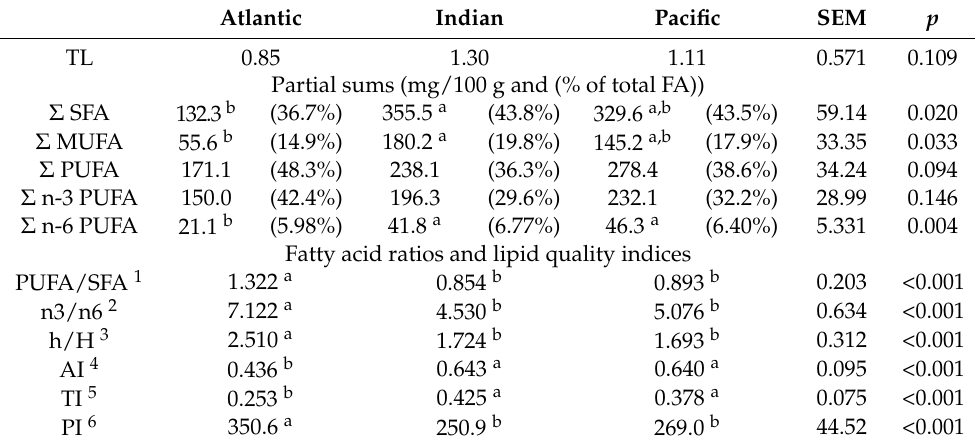
Table 2. Total lipid contents (TL; expressed as g/100 g of flesh), fatty acid partial sums (expressed as mg/100 g of flesh and as % of total FA), fatty acid ratios and lipid quality